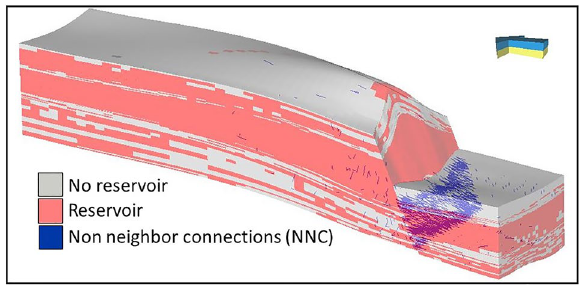
Fig. 3 Definition of the reservoir